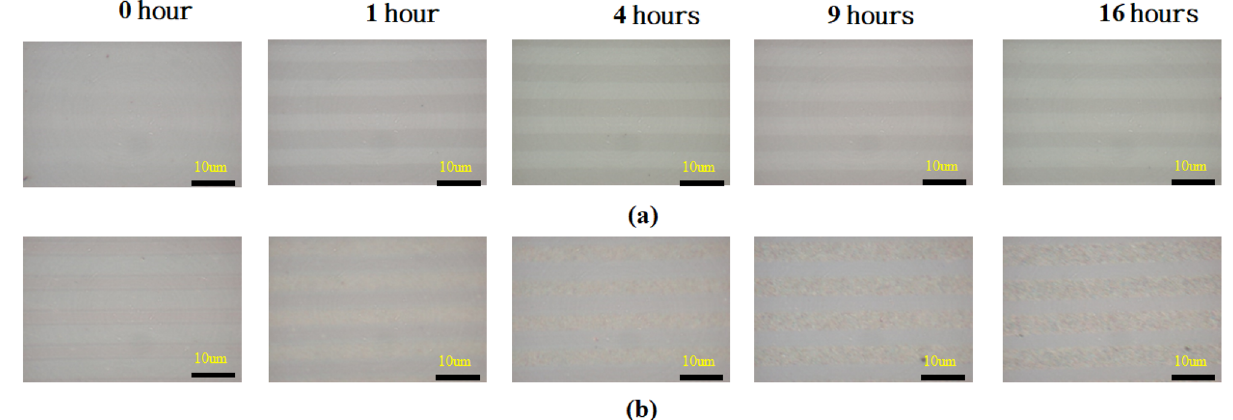
Figure 2. Optical microscope (OM) images of the PPE LiNbO 3 substrates with the different annealing time of 0-h, 1 h, 4 h, 9 h, and 16 h, ( a ) before photoreduction and ( b ) after photoreduction.